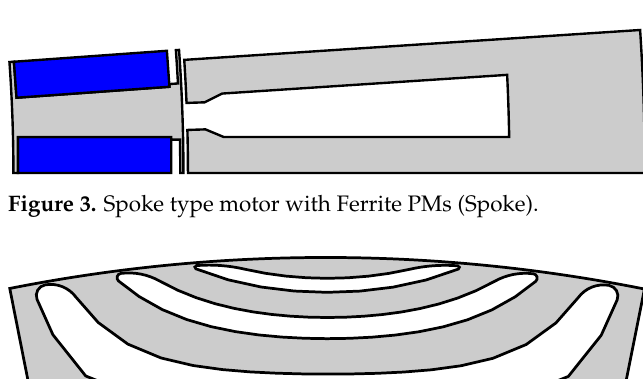
Figure 2. SPM motor with Ferrite PMs (SPM).